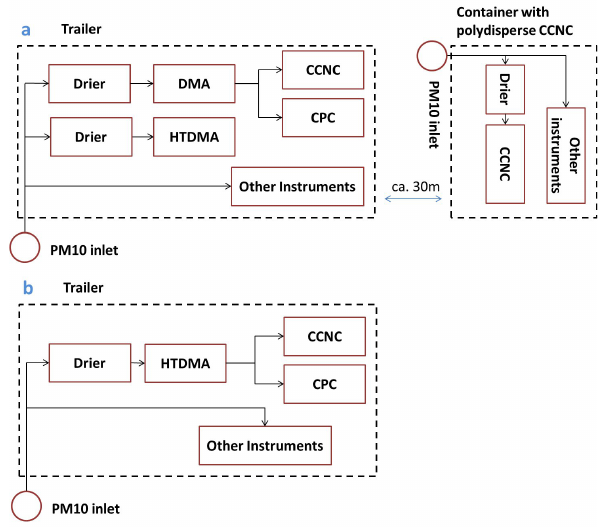
Fig. 1. Measurement setup of the scanning diameter CCNC, poly- disperse CCNC (a) and of the coupled HTDMA–CCNC (b)